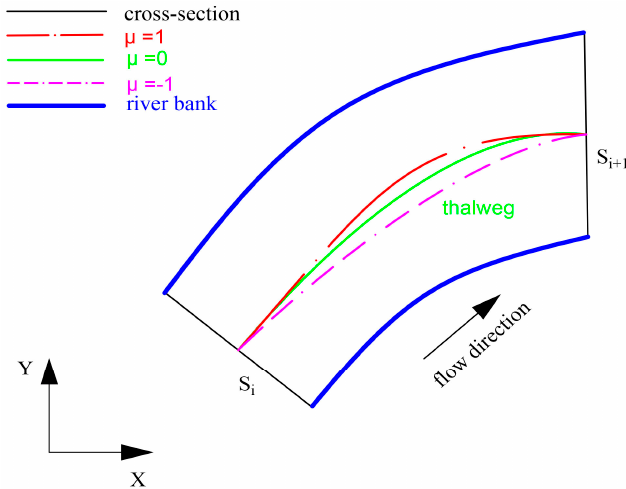
Figure 5. The constructed thalweg affected by different values of the parameter μ .